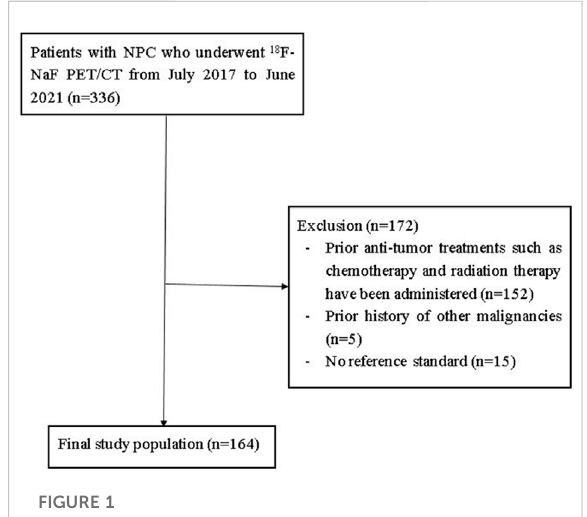
FIGURE 1 Flow diagram of patient selection and exclusion criteria for the initial